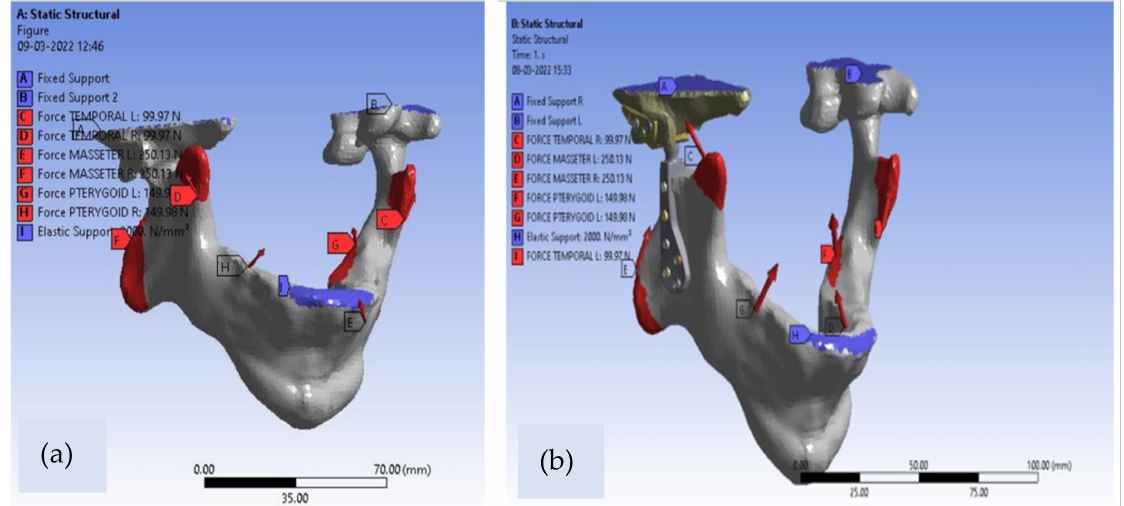
Figure 4. Schematic representation of model constraints (boundary conditions) and load application for FEA in ( a ) intact mandible and ( b ) customized TMJ